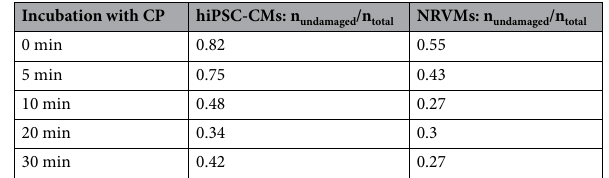
Table 1. The influence of CP on hiPSC-CM and NRVM cytoskeleton in relation to incubation time.